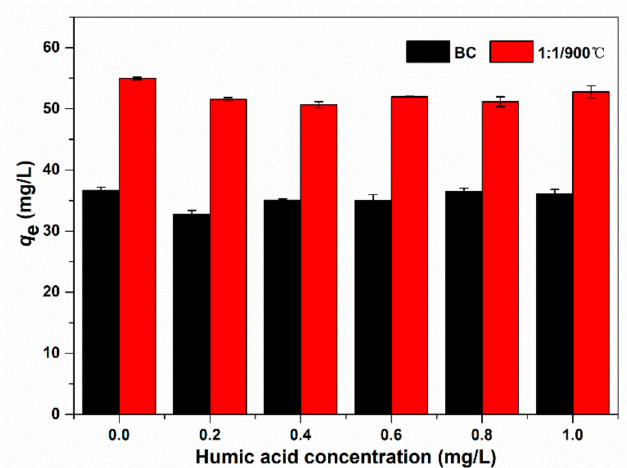
Figure 8. E ff ect of HA on E2 removal by BC and 1:1 / 900 ◦